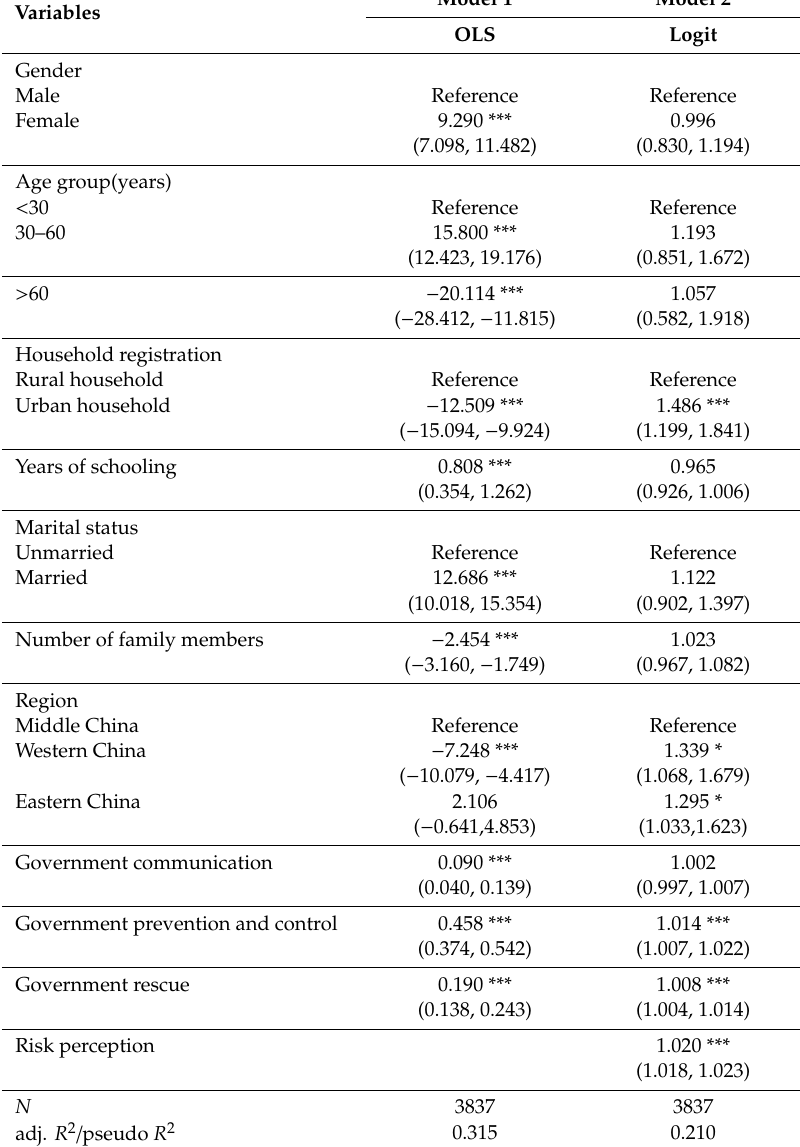
Table 6. Ordinary least squares model predicting risk perception and logit model predicting the public’s adoption of protective action recommendations